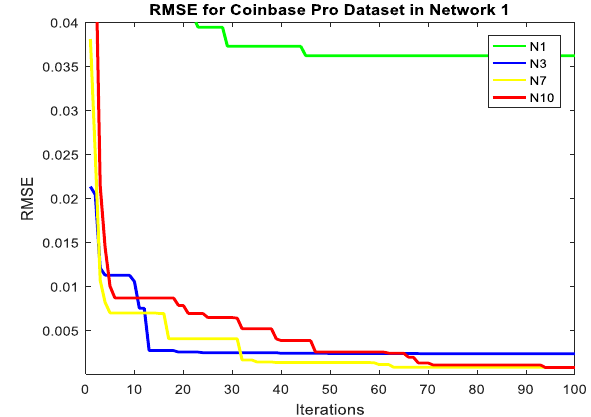
Figure 11. Fitness plot for Coinbase Pro dataset .